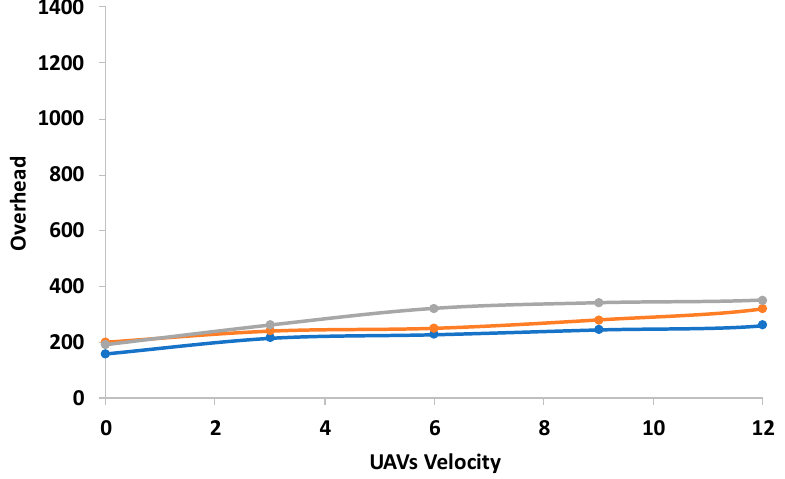
GyTAR Figure 11. Overhead Analysis in the Presence of Different Numbers of UAVs Figure 11. Overhead Analysis in the Presence of Different Numbers of UAVs Nodes.